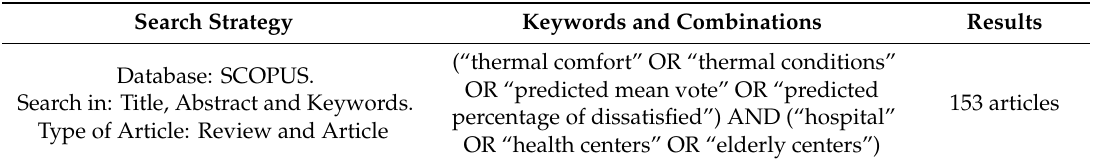
Table 2. Results of search strategy.